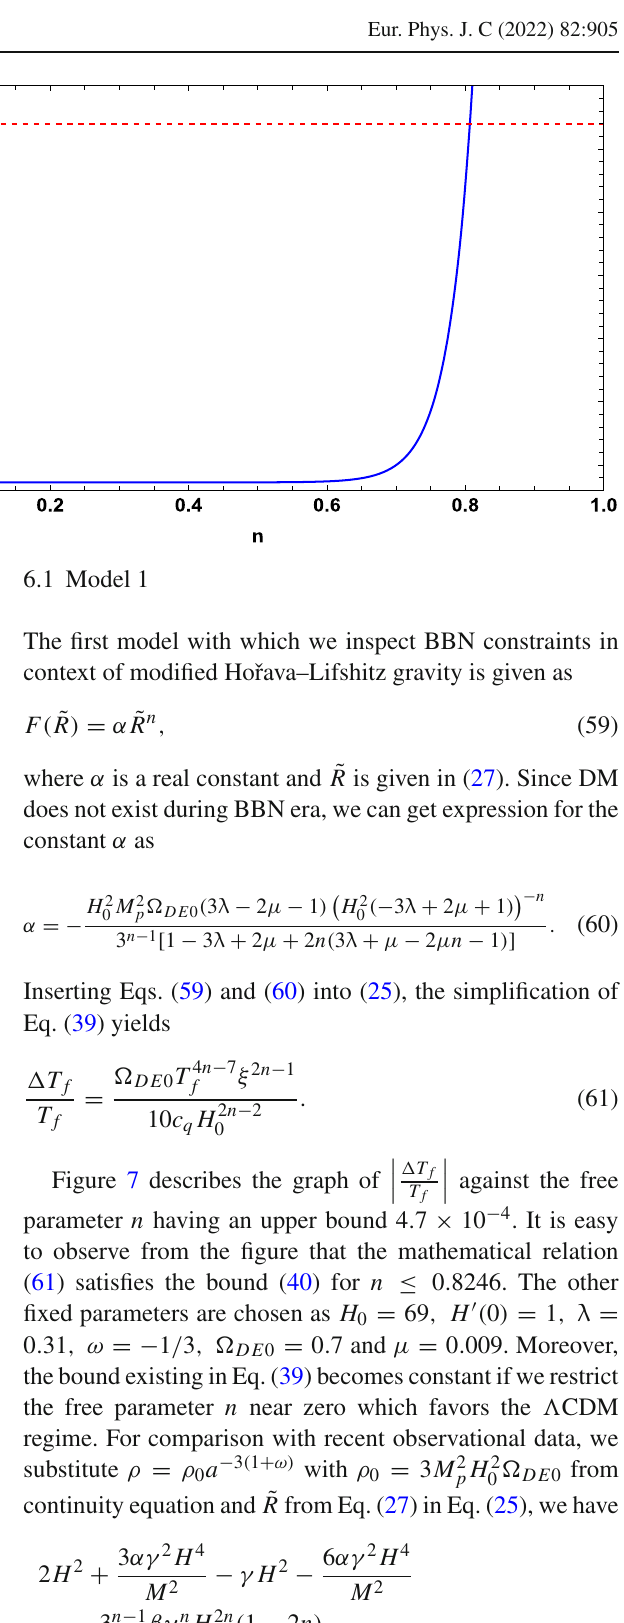
Fig. 5 Variation of in (56) against free parameter n for the model F ( K ) = K + α K 2 + β K n in Einstein-Aether